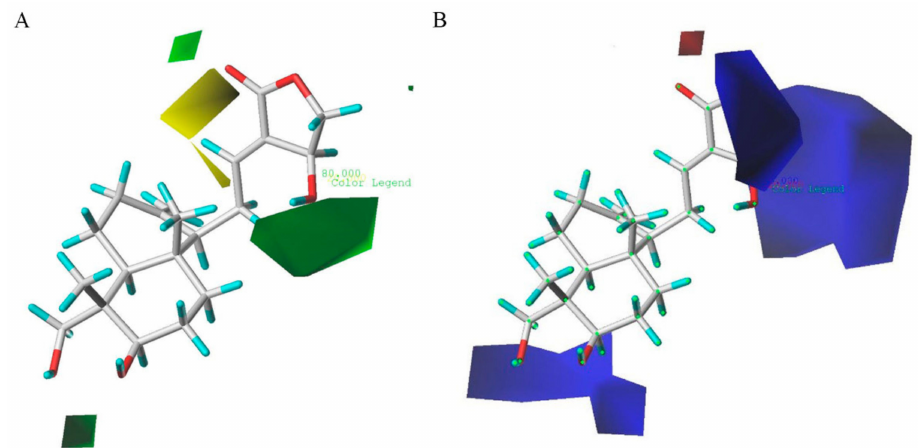
Figure 6. CoMFA Std*Coe ff contour maps in combination with compound AP-6 in group 2. ( A ) Steric field: green and yellow contours indicate regions where bulky groups enhance or reduce the activity, respectively. ( B ) Electrostatic field: blue and red contours indicate regions where electron-donating and electron-withdrawing groups enhance the potency, respectively.